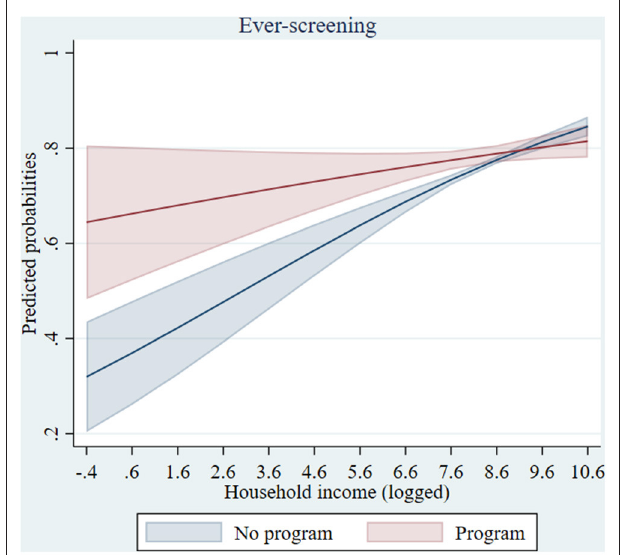
FIGURE 1 | Predicted probabilities of mammography ever-screening by household income in cantons with/without a mammography program (based on model 2a). Confidence intervals were calculated using a multiplier of 1.39 standard errors since two parameters are compared rather than a parameter and a single (fixed) point (Goldstein H, Healy MJR. The graphical presentation of a collection of means. J R Statist Soc . (1995)